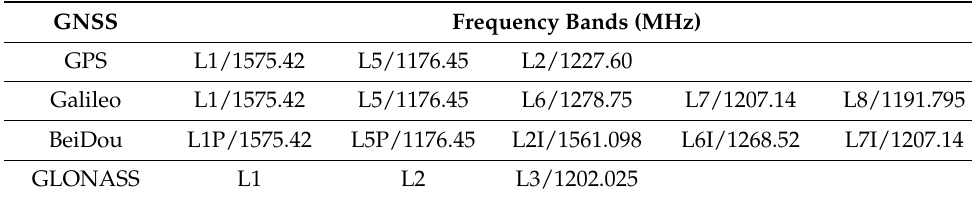
Table 1. Civil signals of multiple